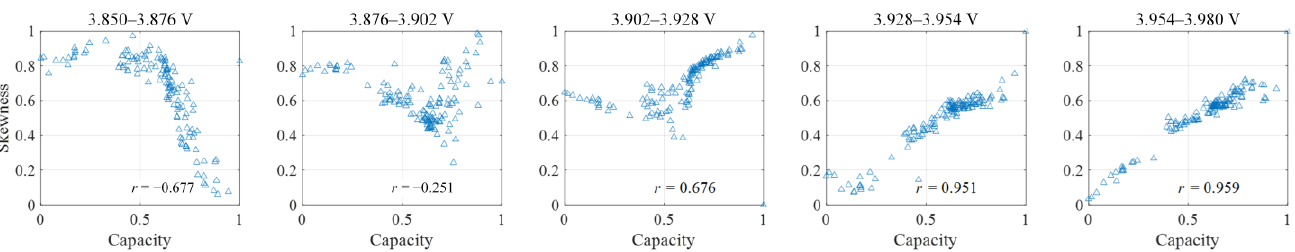
Figure 10. The correlation between capacity and skewness of CALCE.